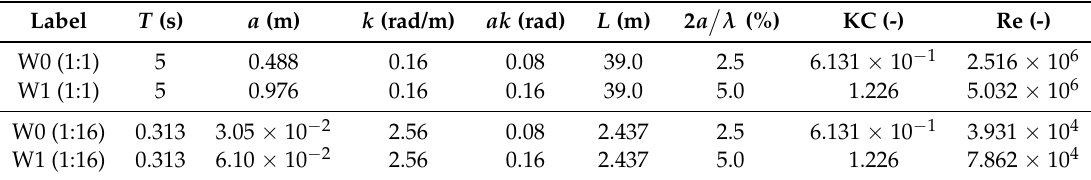
Table 5. Details on the regular wave cases studied. T is period time, L is the wave length (from k ), a is wave amplitude and k is the wave number computed from linear